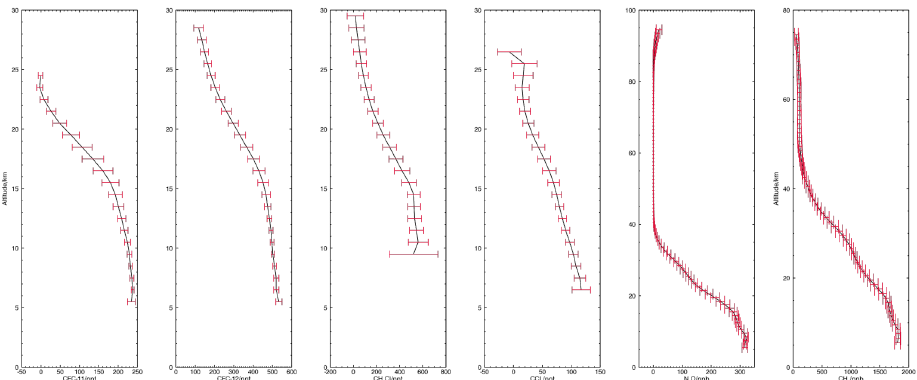
Figure C2 The mean vertical profile of CFC-11, CFC-12, CH3Cl, CH4 & N2O, calculated using data from 2009 between 75° and 60° North Fig. C3. The mean vertical profile of CFC-11, CFC-12, CH 3 Cl, CCl 4 , N 2 O and CH 4 , calculated using data from 2009 between 75 ◦ and 60 ◦ N.